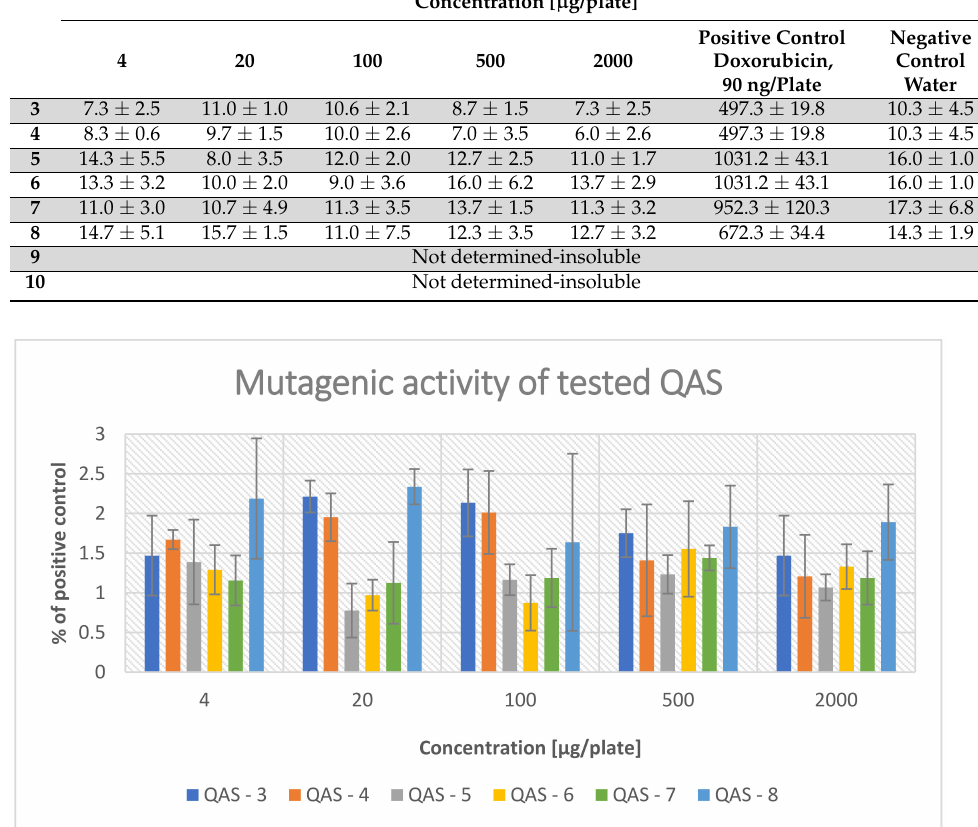
Figure 2. Mutagenic activity of QAS 3–8 presented as % of positive control (doxorubicin, 90 ng/plate) in Ames test with Salmonella typhimurium TA 98